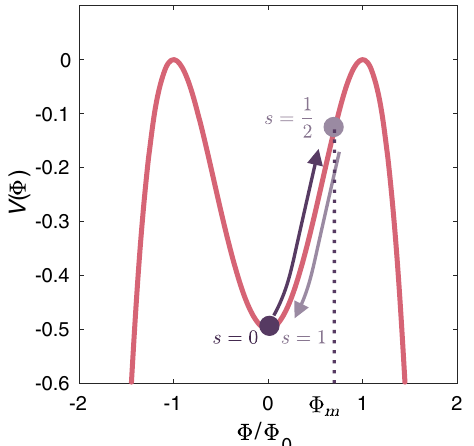
FIG. 8. Soliton shape: Kicked particle in a potential. The potential V ð Φ Þ is plotted versus Φ . At time s ¼ 0 , the particle is located in the potential well (dark circle). It is, however, not at rest as its velocity is nonzero; it is kicked uphill and reaches its maximal position at s ¼ 1 (light circle). It then falls back to its 2 initial position at t ¼ 1 . The particle speeds at s ¼ 0 and s ¼ 1 are opposite. Φ 0 ¼ 1 = 2 , ξ ¼ 1 . This feature translates into a slope discontinuity of the soliton shape at s G